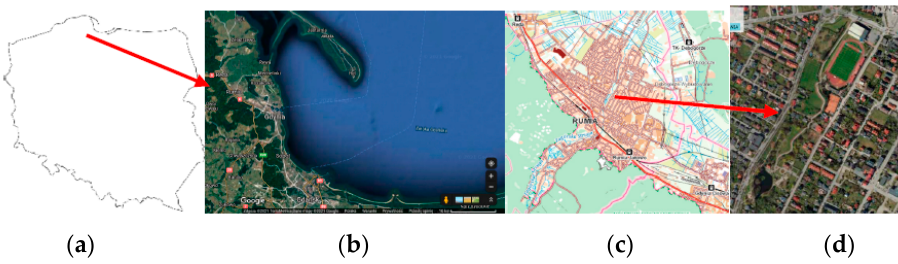
Figure 1. Case study location—Park Starowiejski in Rumia, Poland ( a ) Map of Poland, source: [10], ( b ) Map of Gda´nsk Bay, source [11], ( c ) Map of Rumia, source [12], ( d ) map of Park Starowiejski in Rumia, source